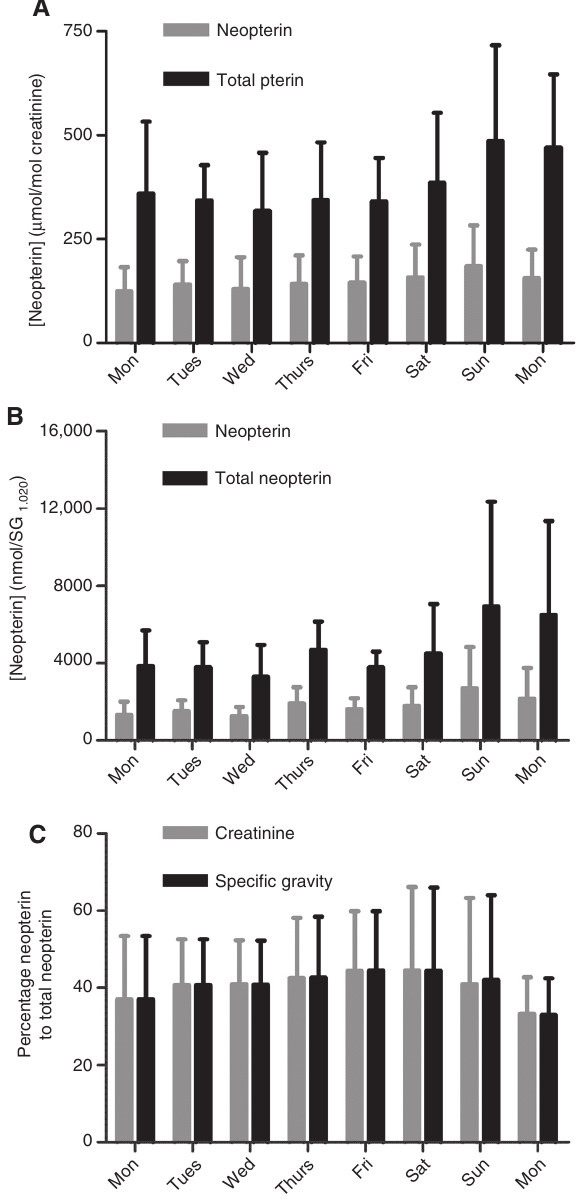
Figure 3 Mean urinary neopterin and total neopterin concentra- tions for the group over 8 days of training with Saturday and Sunday left as rest days (no training). The data shows neopterin and total neopterin (neopterin+7,8-dihydroneopterin) corrected for urine volume using either creatinine (A) or specific gravity (B). There was no significant change in the percentage of neopterin to total neop- terin (C) over the week of analysis for the group data whether it was corrected using creatinine or specific